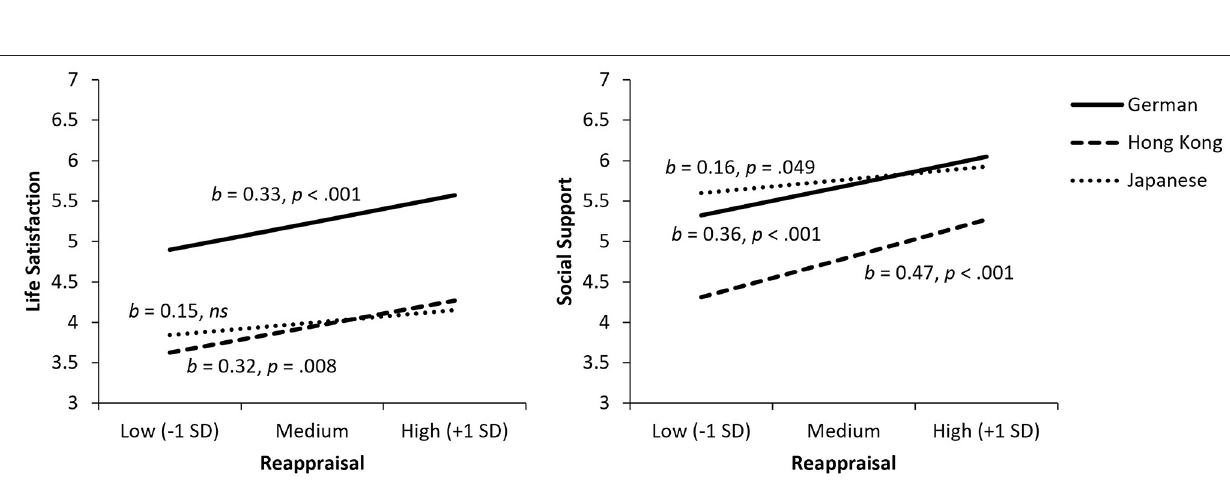
FIGURE 1 | Relationships of suppression with life satisfaction (left) and social support (right). ns, not statistically significant.